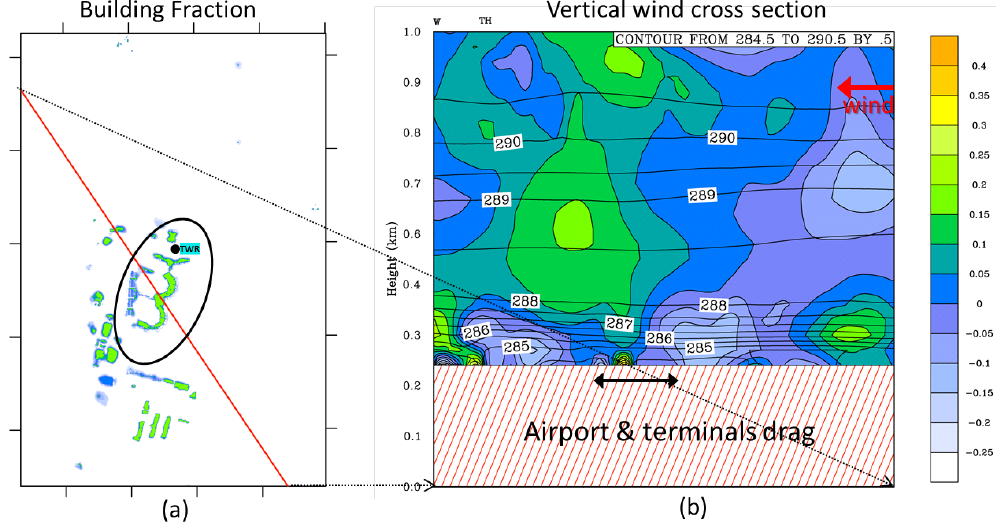
Figure 5. ( a ) Surface building fraction (green surfaces represent the airport’s terminal and buildings) and ( b ) Vertical cross-section of the vertical wind component in m/s for the colored isolines and contours of potential temperature (white labels in